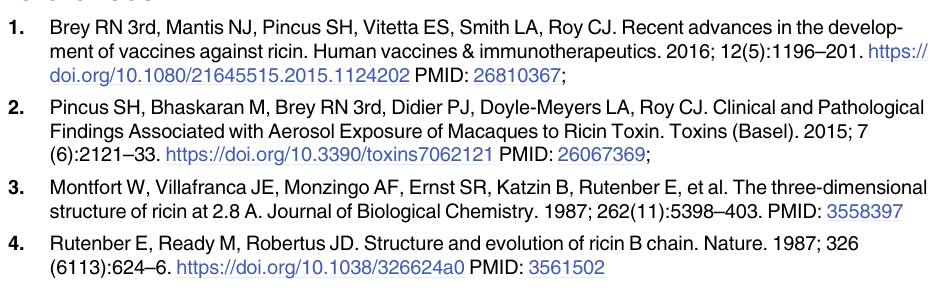
proposed epitope (green) and the relative spatial distribution (red circles) of epitopes recog- nized by MH3, 8B3, 8A1, and LF1 based on competition ELISAs presented in Table 2. Resi- dues are non-conserved residues between RTB and RCB are colored orange. S6 Fig. Passive protection studies with anti-RTB mAbs. Passive protection studies in which groups of adult BALB/c mice (n = 5 per experiment) were injected intraperitoneally with indi- cated mAbs and then challenged 24 h later with ricin (2 μg; 10 x LD ) by the ( A ) intraperito- 50 neal or ( B ) intranasal route. Survival was monitored for seven days. S7 Fig. Putative duplication of 8B3’s epitope on RTB. ( A ) Manual alignment of subdomains 1 α and 2 γ from RTB (PDB ID 2AAI) and RCA-I’s B subunit (RCB; PDB ID 1RZO). Boxed in bold, conserved residues; boxed, conservative substitutions; (cid:3) , surface exposed residues that are conserved/conservative between RTB and RCB. These same residues are colored red in Panels B and C. (B,C ) PyMol image of ricin (PDB ID 2AAI) showing potential binding sites of 8B3 on subdomains 1 α and 2 γ of RTB. Residues in red are surface exposed and conserved/con- servative between RTB and RCB, as indicted in Panel